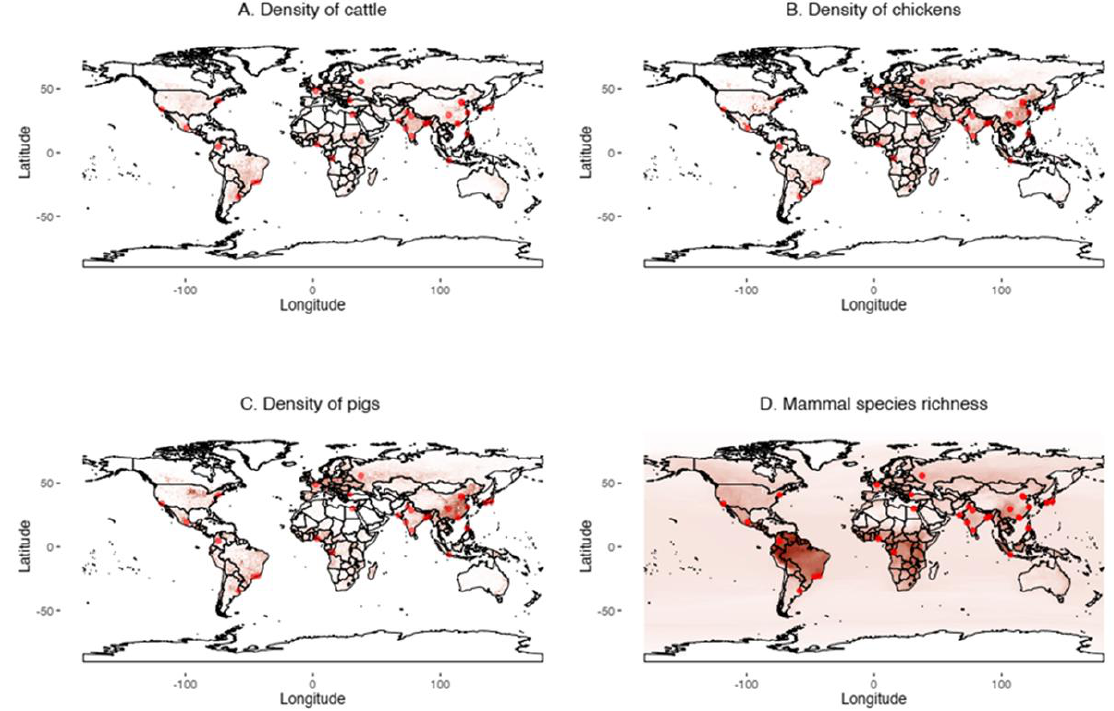
Figure 1: Changes in rural (A) and urban (B) population size from 1960 to 2050 (note the sharp increase in urban population in tropical regions) and in the number and size of large cities from (C) 1950, (D) 1975, (E) 2000 and (F) 2025 (data from the World Bank,